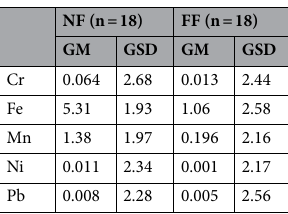
Table 4. The GMs and GSDs (mg/m 3 ) of the field metal fume concentrations in the NF and FF regions of the welders.